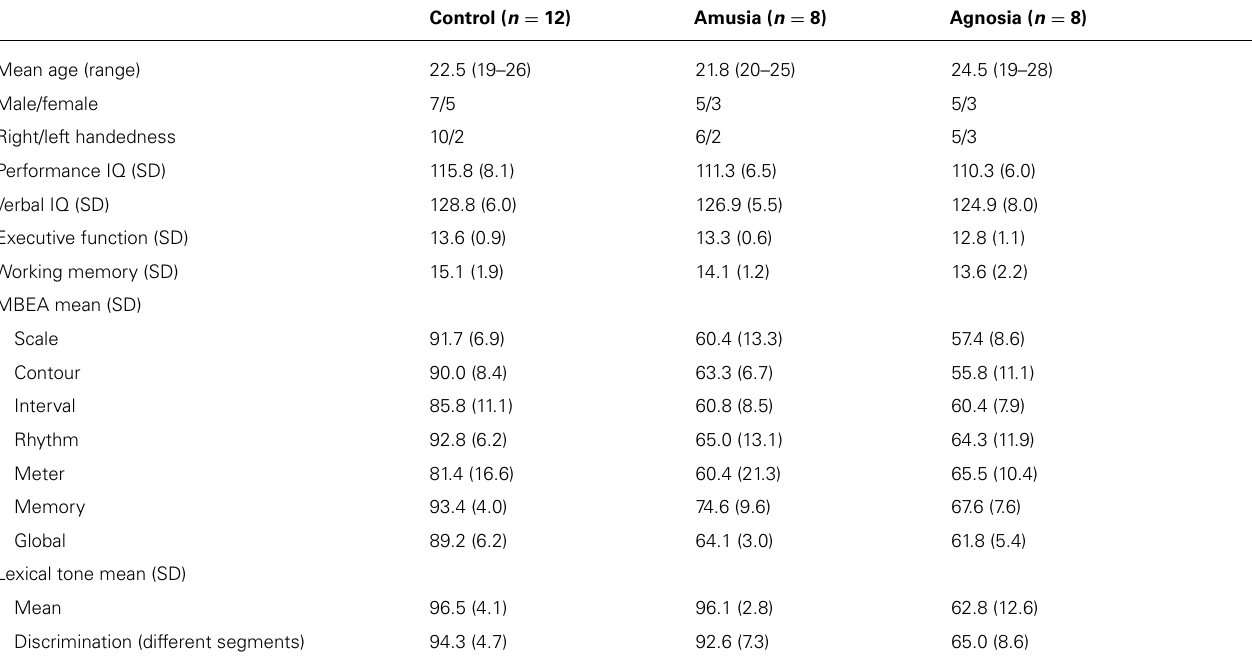
Table 1 |The characteristics of the controls, the amusics, and the tone agnosics with percentages of correct responses on the MBEA and lexical tone perception tests.